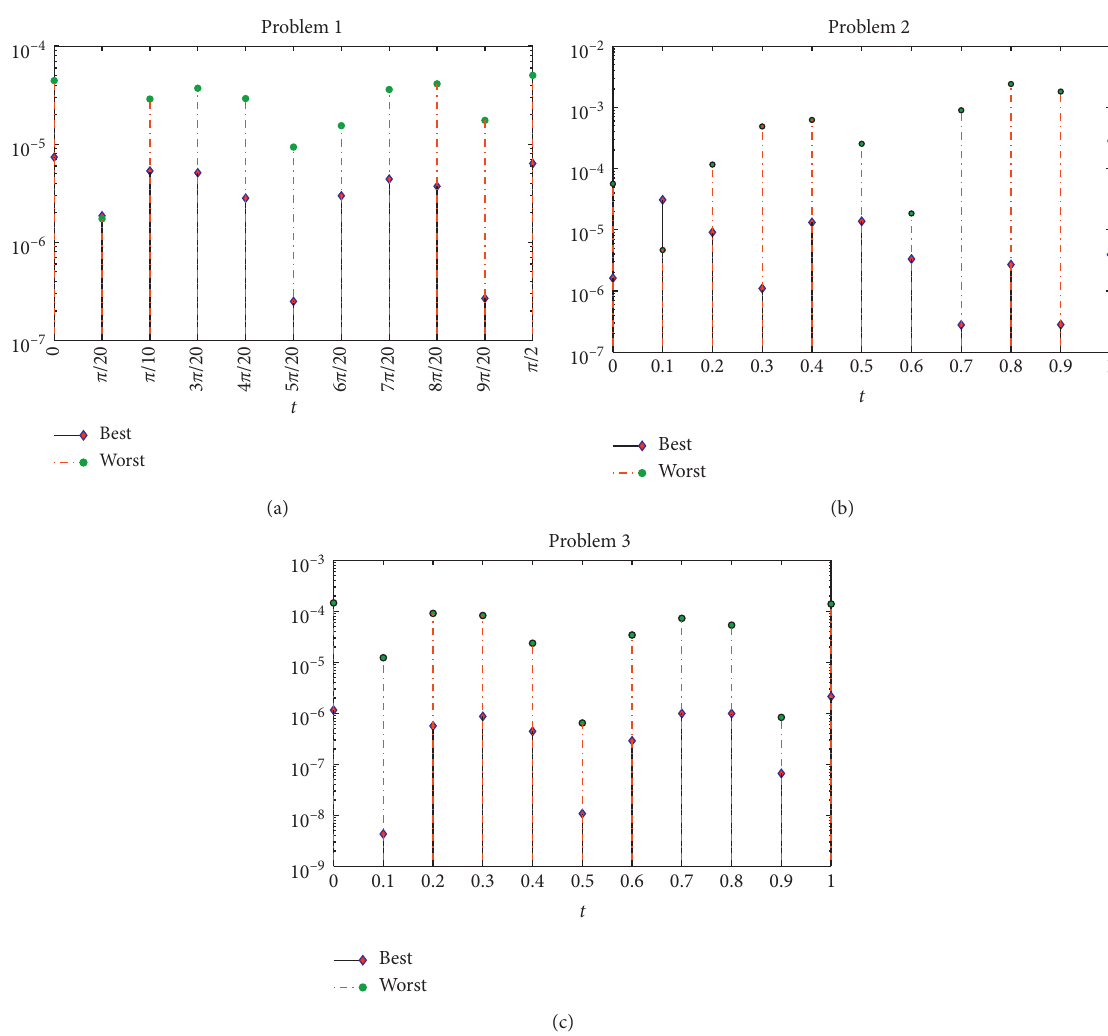
Figure 6: Comparison between best and worst absolute errors for Problems